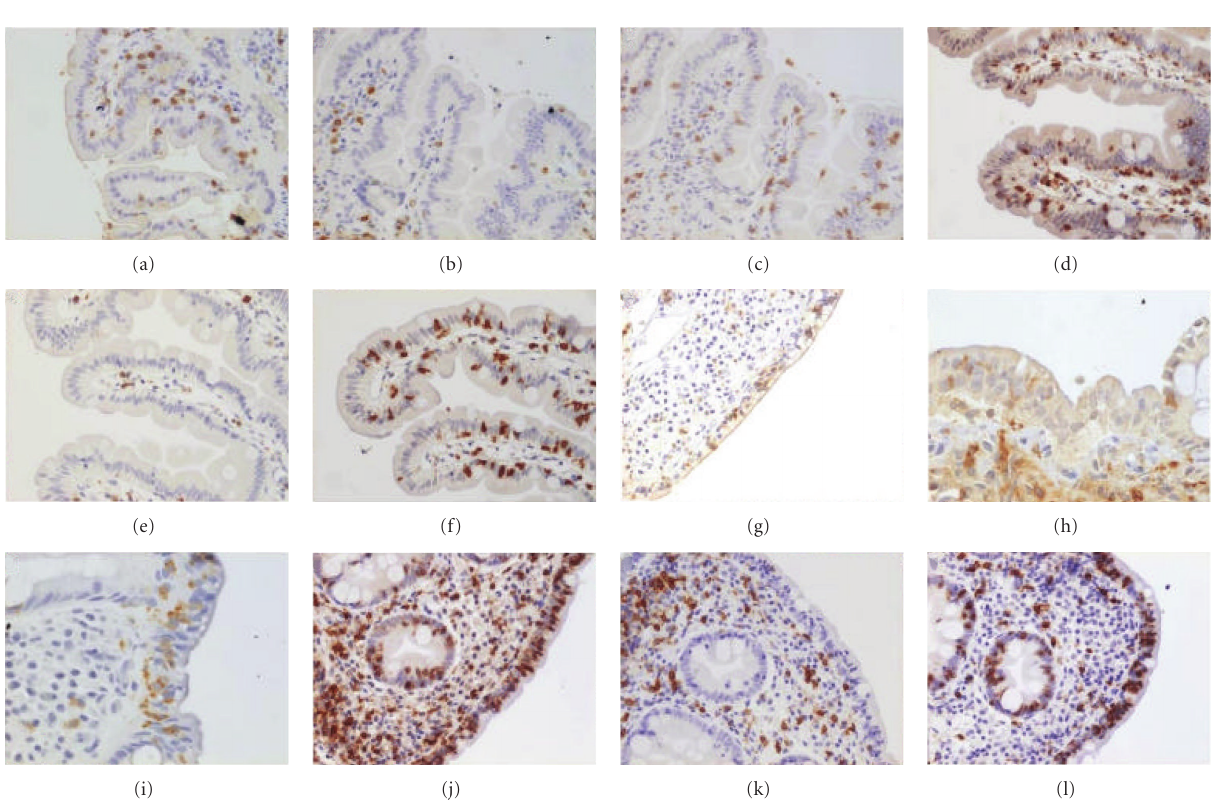
Figure 1: Immunohistochemical staining for CD3, CD4, and CD8 in the four di ff erent groups. Controls: (a)-CD3, (b)-CD4, (c)-CD8 (all o.mX200); Hp+/CD-: (d)-CD3 (o.mX400), (e)-CD4 (o.mX200), (f)-CD8 (o.mX200); Hp-/CD+: (g)-CD3 (o.mX200), (h)-CD4 (o.mX400), (i)-CD8 (o.mX400); Hp+/CD+: (j)-CD3, (k)-CD4, (l)-CD8 (all